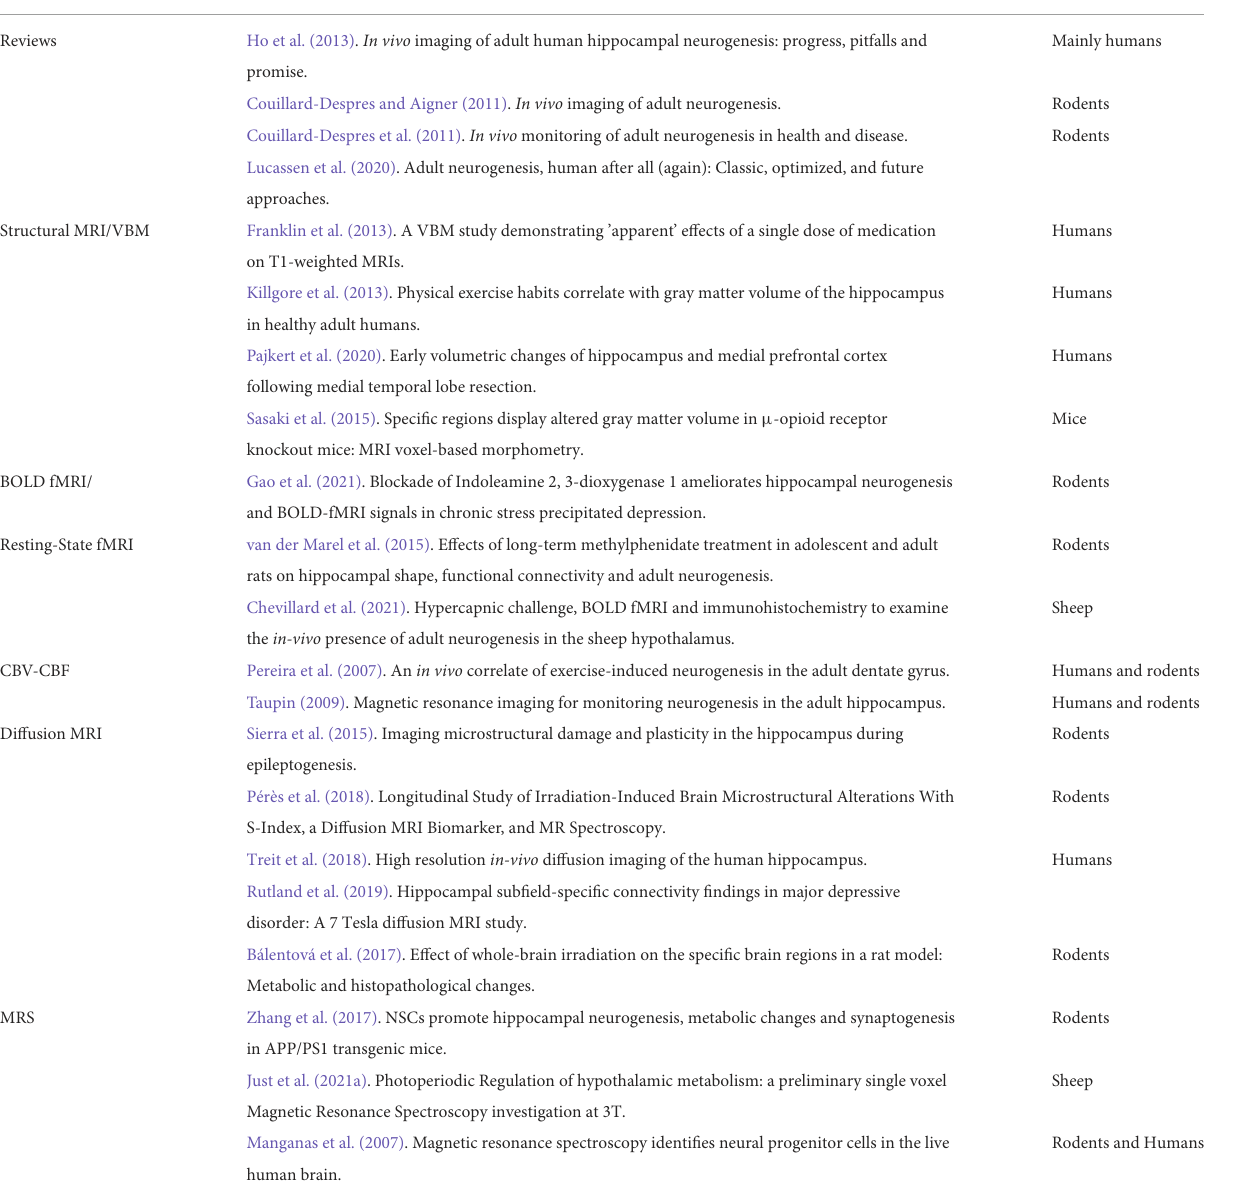
TABLE 1 MR publications on adult